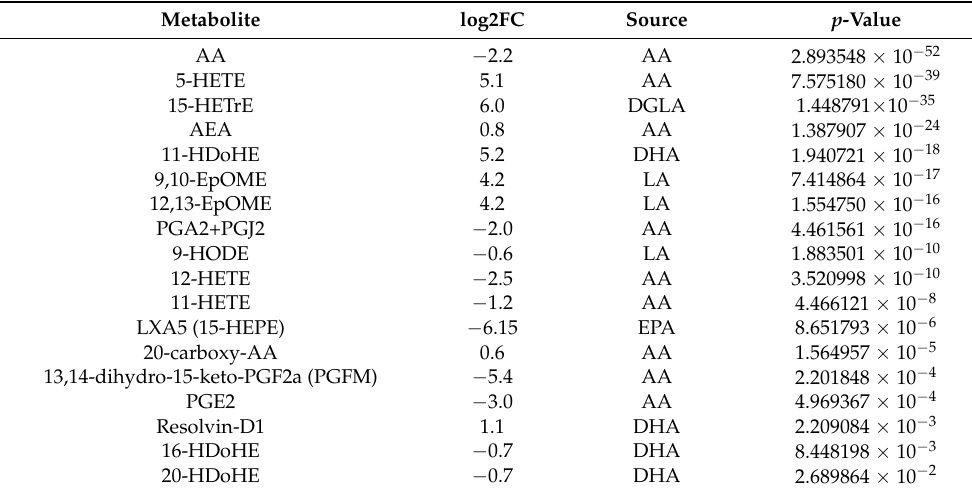
Table 2. Summary of the 18 identified metabolites and their statistical values.